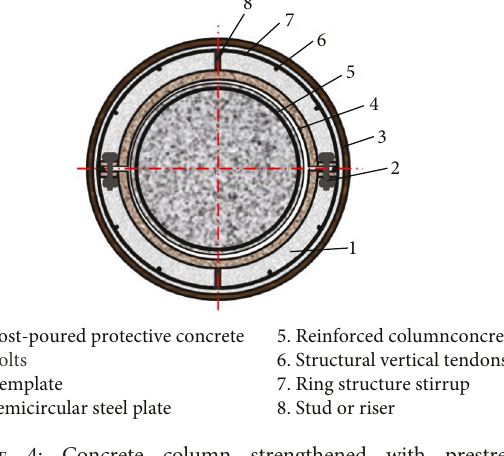
Figure 4: Concrete column strengthened with prestressed semicircular steel